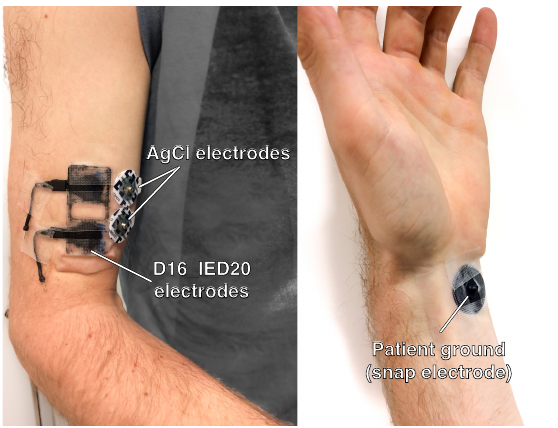
Figure 5. Placement of the electrodes on the subject biceps and